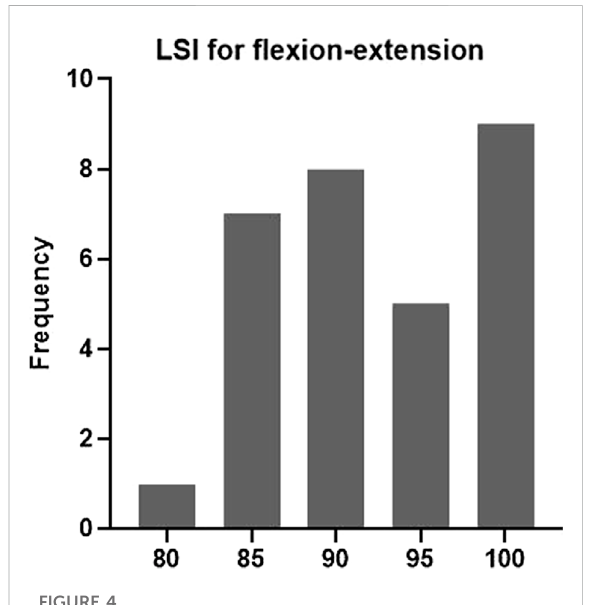
FIGURE 4 Frequency distribution of fl exion-extension angle